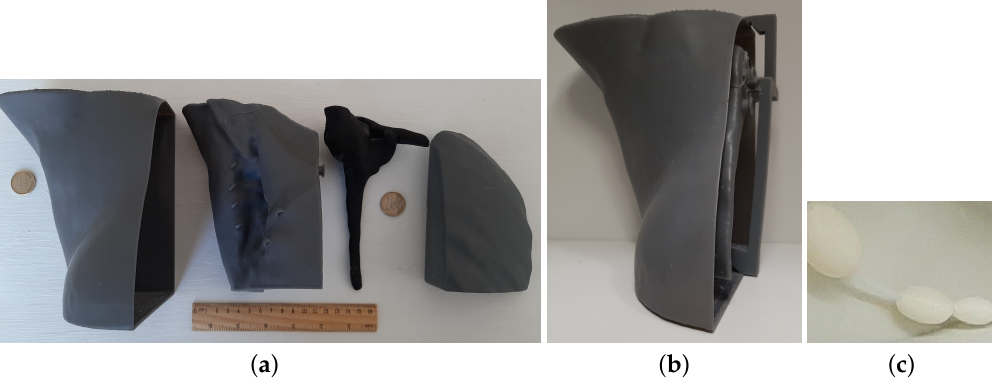
Figure 8. Three-dimensional-printed phantom. ( a ) From left to right: (i) torso, (ii) muscle, (iii) bone, and (iv) lung cavities, together with the iii) bone structure are represented. ( b ) Assembled phantom, where we can observe an extra part which keeps the organs in place inside the other container. ( c ) Three ellipsoidal hollow axillary lymph nodes, with a wire passing through